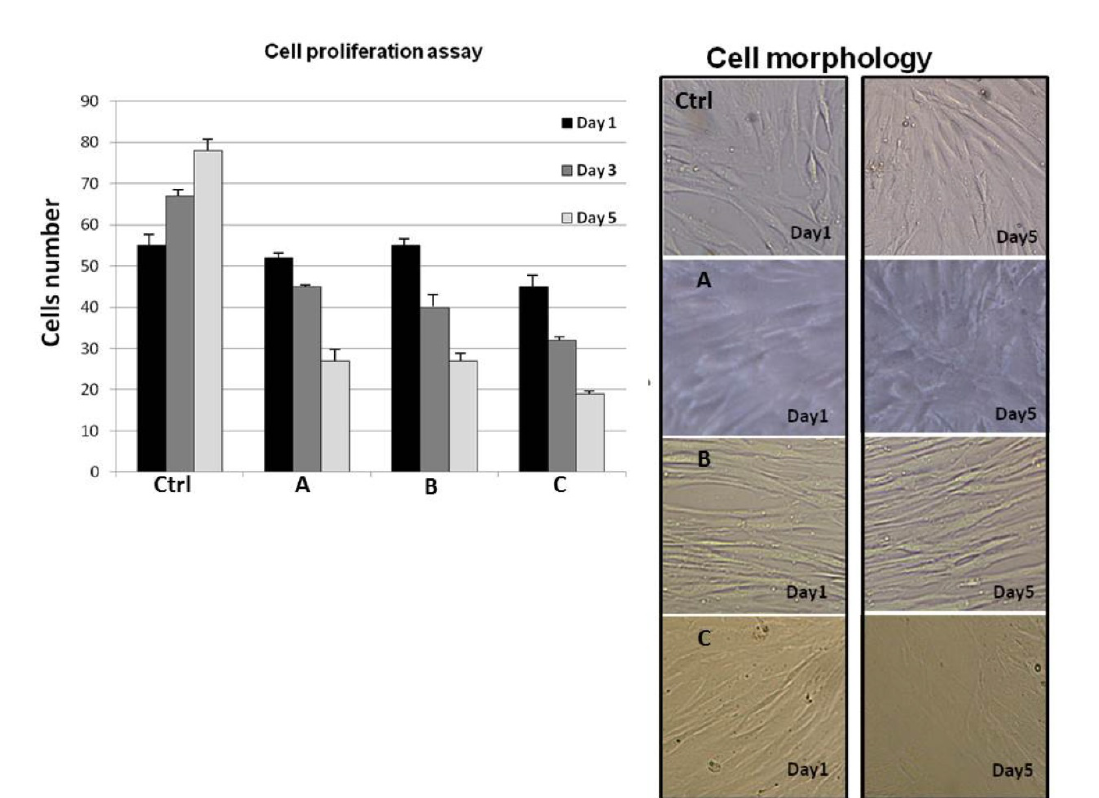
Figure 3: Cell proliferation assay. Human Osteoblasts were placed into Osteoblasts Medium in 4 wells and each of the specimens in 3 different wells, while 1 well was leaved empty and was marked as control. Cell count was performed at day 1, day 3 and day 5. Cell proliferation assays were performed in triplicate. Cell morphology. Human Osteoblasts were cultured on 3 glass-ionomer cements to assess if the cell phenotype was different between day1 and day5 time point: the used glass-ionomer cements were named A, B and C. Control was assumed to be the tissue culture